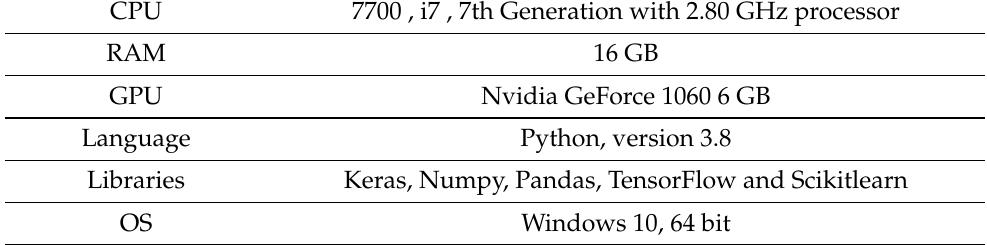
Table 4. Experimental